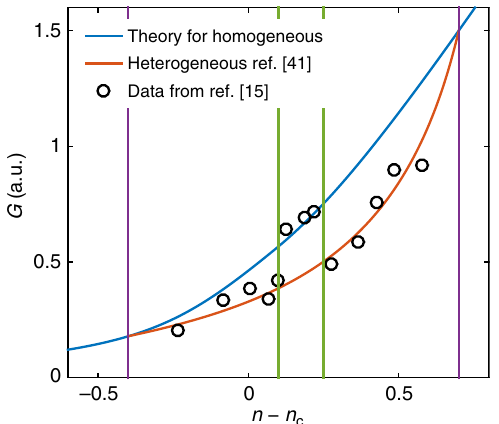
Fig. 5 Experimental evidence of structural heterogeneity. Shear modulus G in arbitrary unit predicted for homogeneous networks (blue) and for heterogenous networks composed of two phases at ends (red). Black circles are Raman shift data of the transverse optical (TO) branch ν 2 = ν 2 (cid:2) 1 in ref. 15 . The green and purple lines indicate the boundaries of 0 TO intermediate phase and separation range, as in Fig.